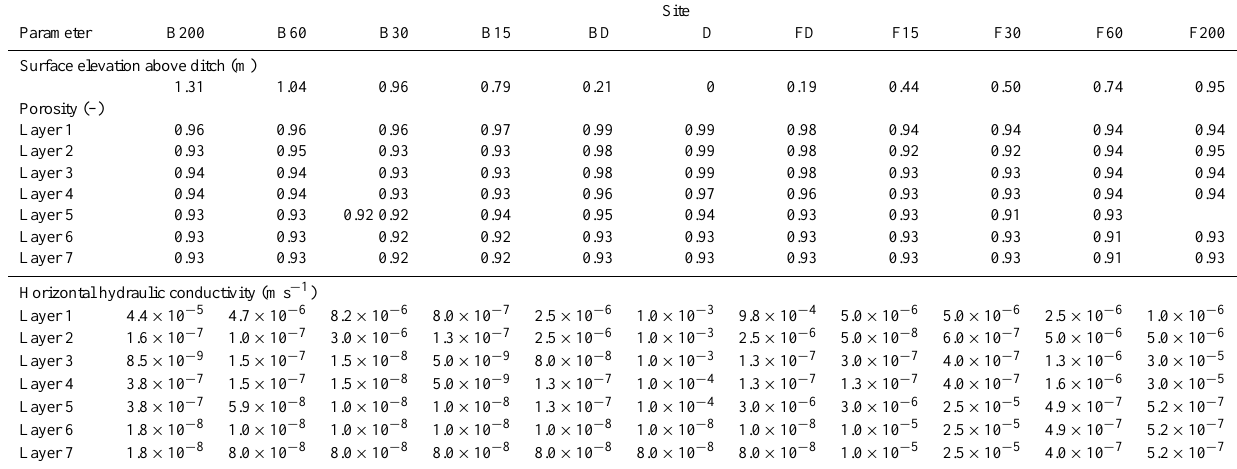
Table 1. Porosity and hydraulic conductivity estimates for each layer implemented in the steady-state and transient MODFLOW models. Site Parameter B200 B60 B30 B15 BD D FD F15 F30 F60 F200 Surface elevation above ditch (m) 1.31 1.04